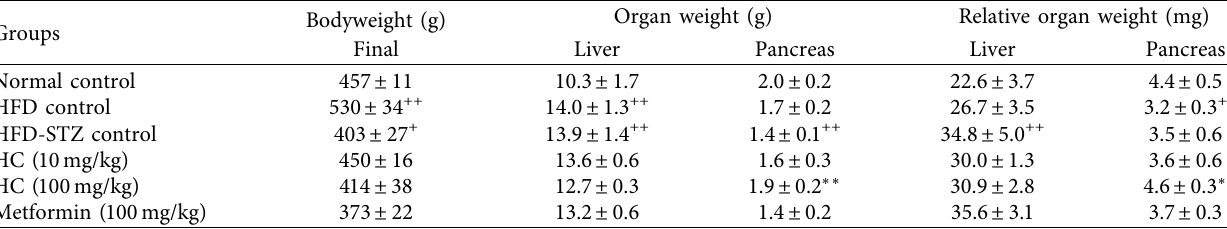
Figure 2: Effect of HFD on rat characteristics. (a) Bodyweight and (b) fasting blood glucose in normal and high-fat diet groups after 4 weeks of consumption. + p < 0 . 01 and ++ p < 0 . 001 versus normal control group. Results are presented as means ± SD ( n � 6 each group). Table 1: Relative liver and pancreas weight in each group.